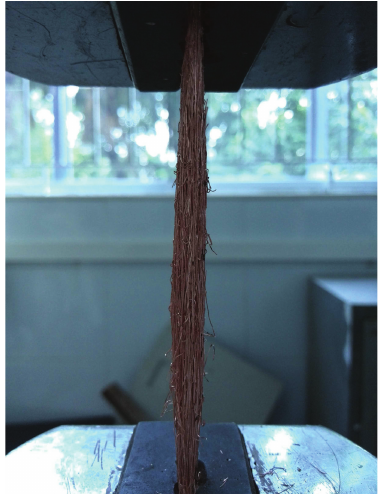
Figure 6: Fracture image of the OLPM in the thickness direction.